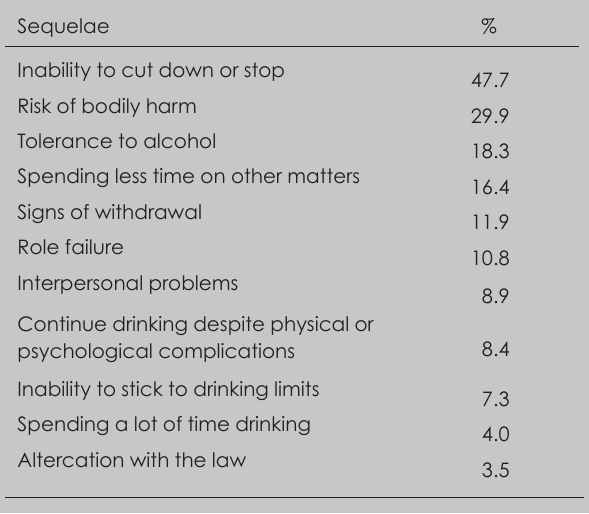
Table III. Students’ self-reported behavioural, physical, psychological and social sequelae of alcohol use, based on DSM-IV criteria for alcohol abuse and dependence 12